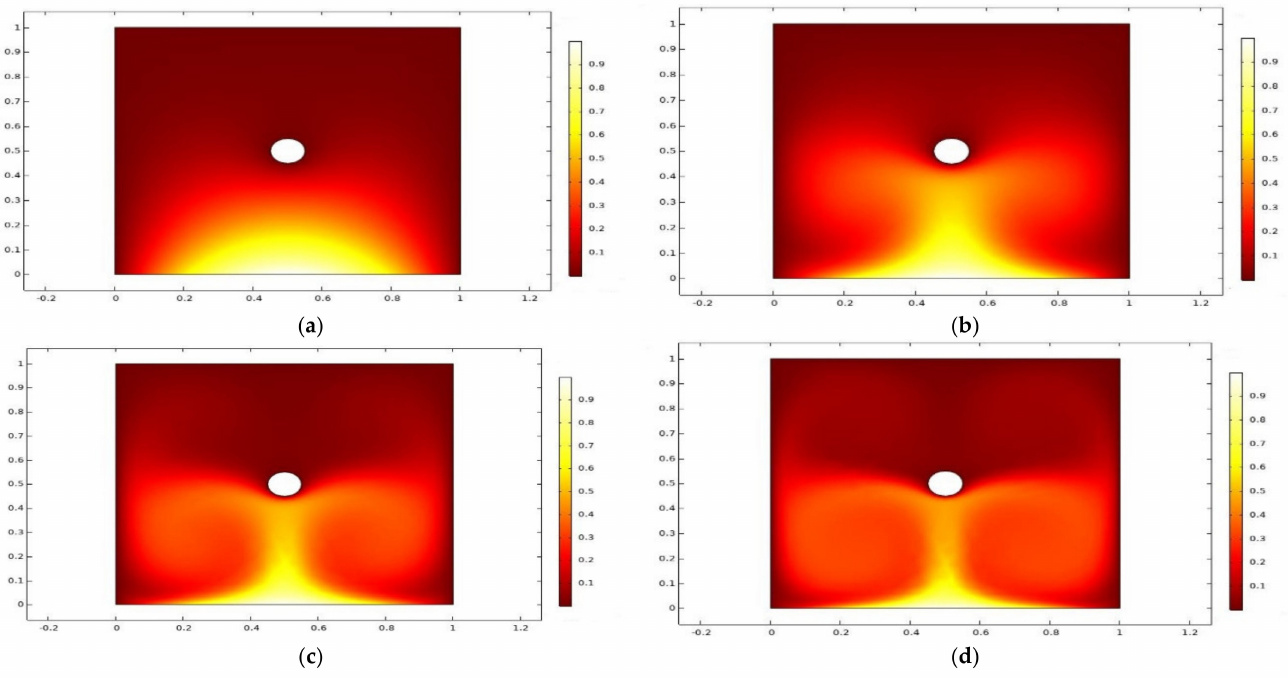
Figure 6. Impact of Rayleigh number ( Ra ) on temperature distribution ( a ) Ra = 100, ( b ) Ra = 10 3 , ( c ) Ra = 10 4 , ( d ) Ra = 10 5